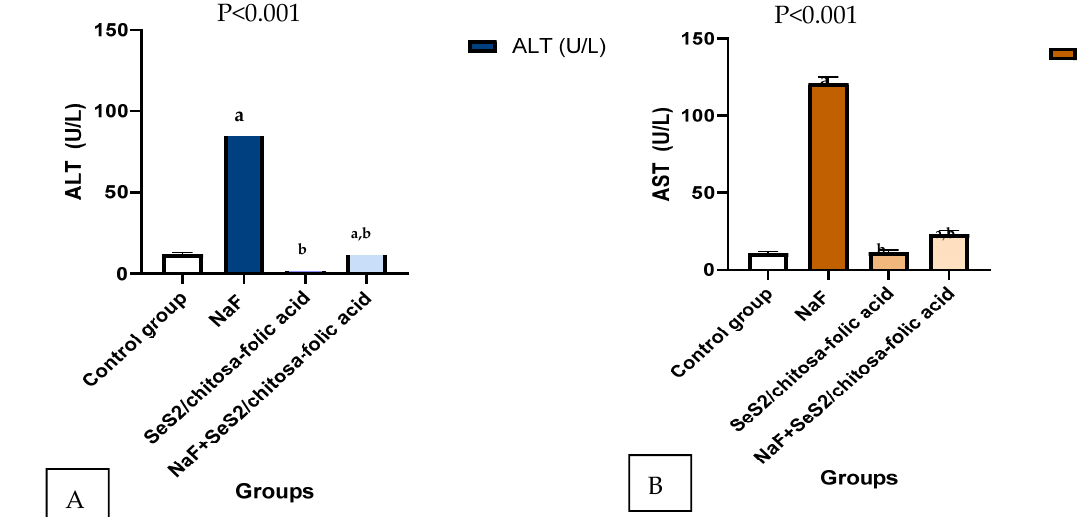
Figure 7. Se/chitosan-folic acid novel complex ameliorated serum ALT and AST in NaF-exposed male rats. Data are mean ± SEM, n = 10. ( A ) Alanine aminotransferase; ( B ) Aspartate aminotransferase. Where (a) is significant to the control group, (b) is significant to the NaF treated group.